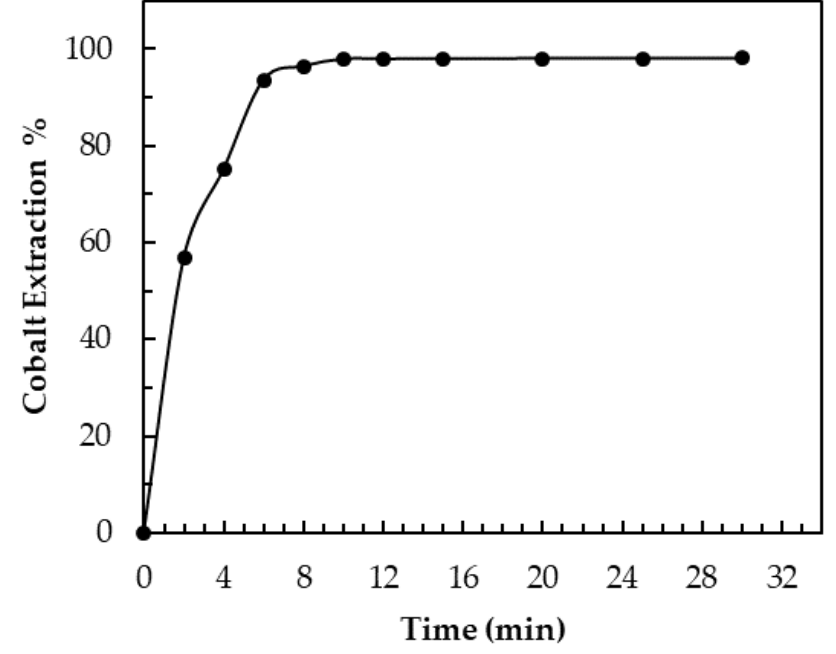
Figure 9. Extraction at A/O = 1, Xi = 10.2 g/L, [Cyanex 272] = 0.4 mol/L, pH = 6, and temperature = 22 ± 1 °C.